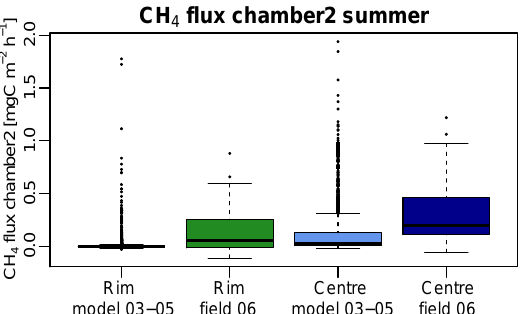
Figure 6. Modelled methane flux out of soil at the rim and cen- tre compared to chamber measurements. Modelled values are only from the summer periods 2003 to 2005, which means less than 5cm of snow are on the ground. Field measurements took place on 39 days from July to September 2006. Because of the wide spread of high modelled values, to as high as 86.8mg Cm − 2 h − 1 , a portion of 0.347% modelled values was cut to provide a reasonable picture. The minimum of the modelled values is − 0 . 0237mg Cm − 2 h − 1